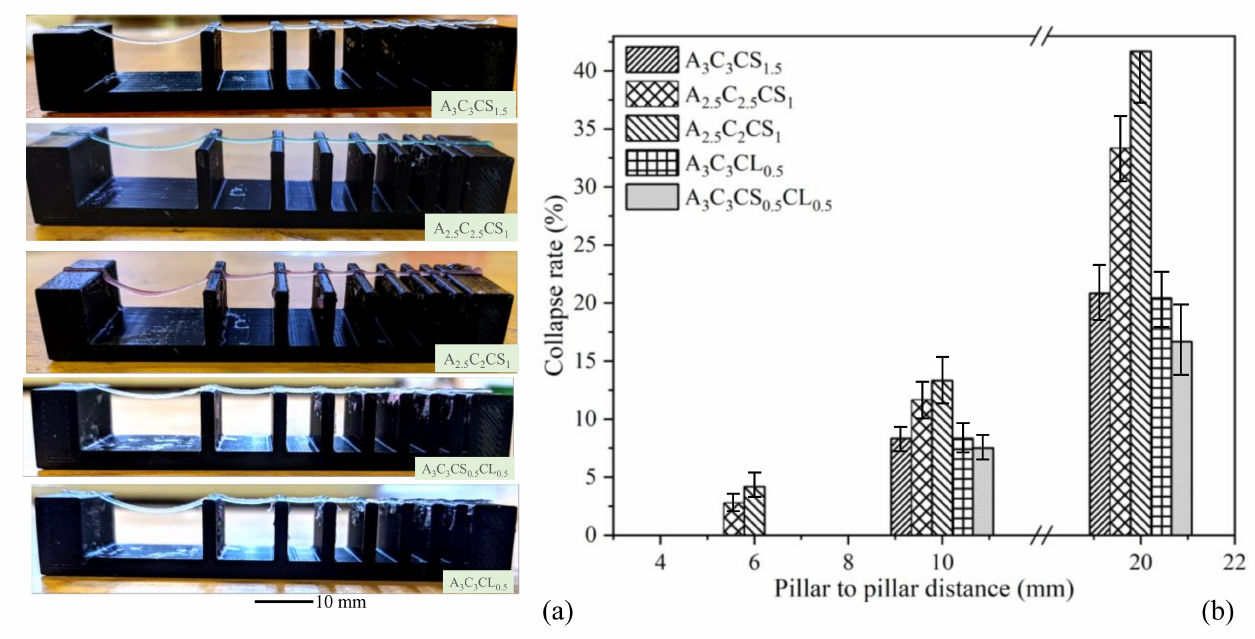
Figure 11. ( a ) Collapse test and ( b ) test result. From 1–5 mm pillar-to-pillar distance, none of the compositions showed collapse. We observed collapse started with a pillar-to-pillar distance of 6.0 mm, and it increased with increasing the pillar-to-pillar distance. At a pillar-to-pillar distance of 20.0 mm, we observed the collapse rate ranging from 20.83 to 41.67%.